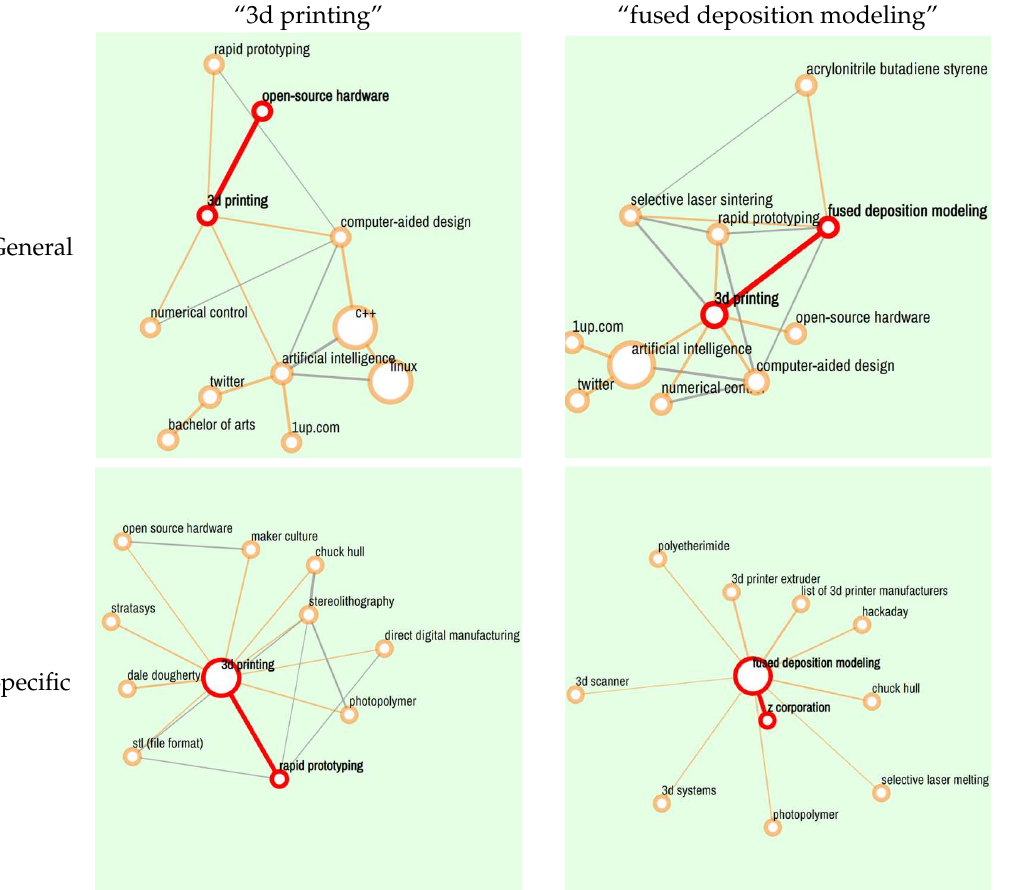
Figure 5. Retrieval results for “3d printing” and “fused deposition modeling” in “Explore-General” and “Explore-Specific”